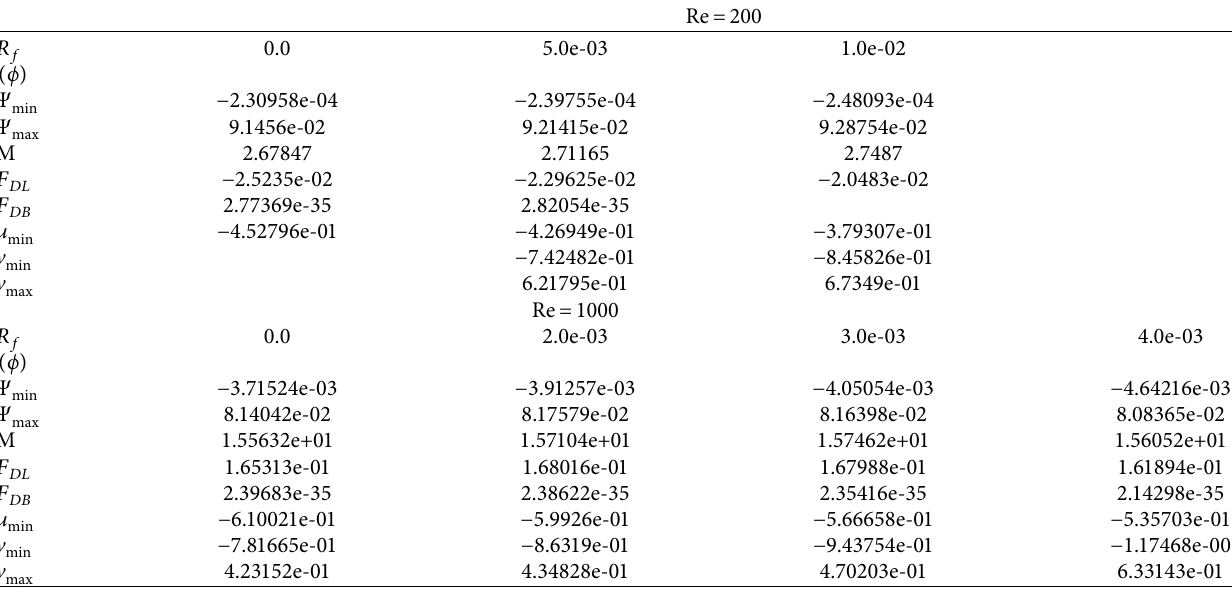
Table 3: Variable of interest ϕ for Re � 200 and Re � 1000 with varying values of the fluid relaxation